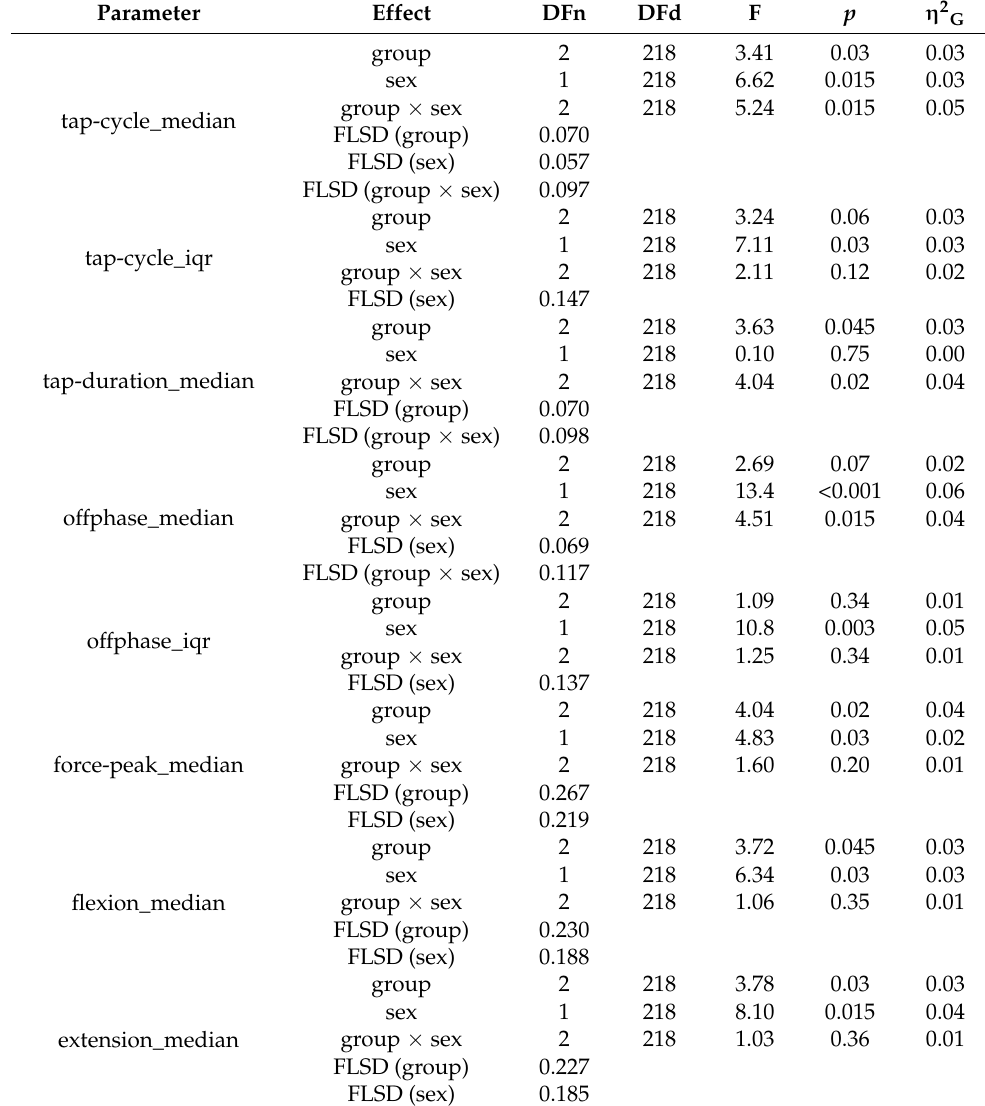
Table 4. ANOVA results for the fast pace condition. Only parameters with significant differences ( p < 0.05) in at least one effect are shown. p values are false-discovery-rate-corrected for multiple